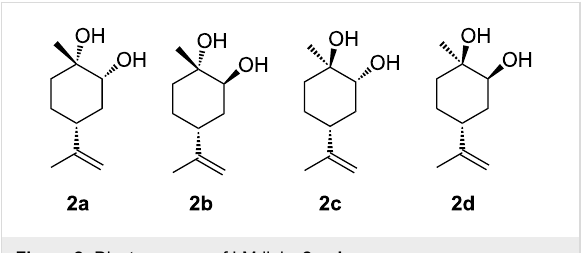
Figure 2: Diastereomers of LMdiols, 2a – d